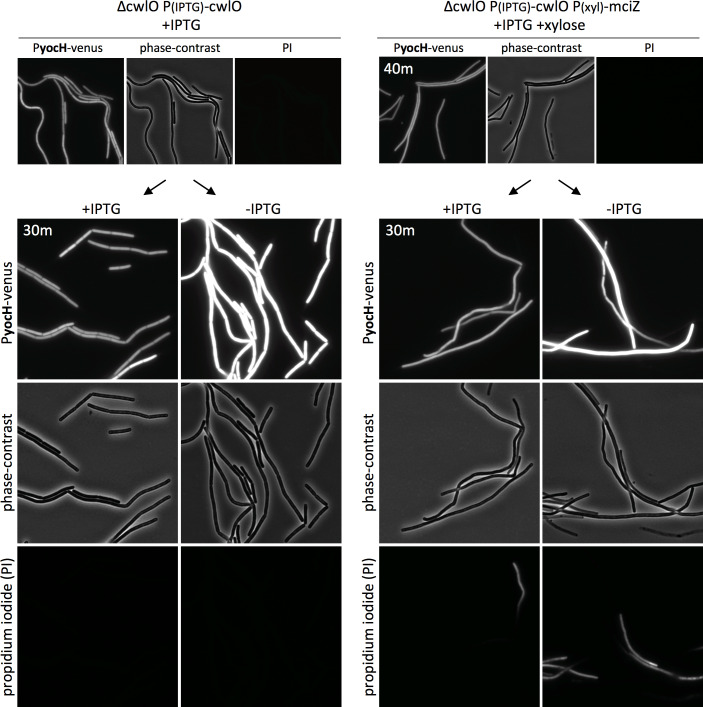
Loss of membrane integrity in cells inhibited for divisome assembly.Representative fluorescence and phase-contrast images of strains harboring PyocH-venus before and 30 min after removal of IPTG to shut off cwlO transcription. The images on right are from a strain that also contained the FtsZ inhibitor MciZ under xylose control (P(xyl)-mciZ) and was grown in the presence of 10 mM xylose for 40 min, prior to IPTG removal. Prior to imaging, cells were incubated with 5 mM propidium iodide (PI) to assess membrane integrity as an indicator of viability. Some of the filaments expressing mciZ were PI positive and these did not increase transcription of PyocH-venus when CwlO was depleted.